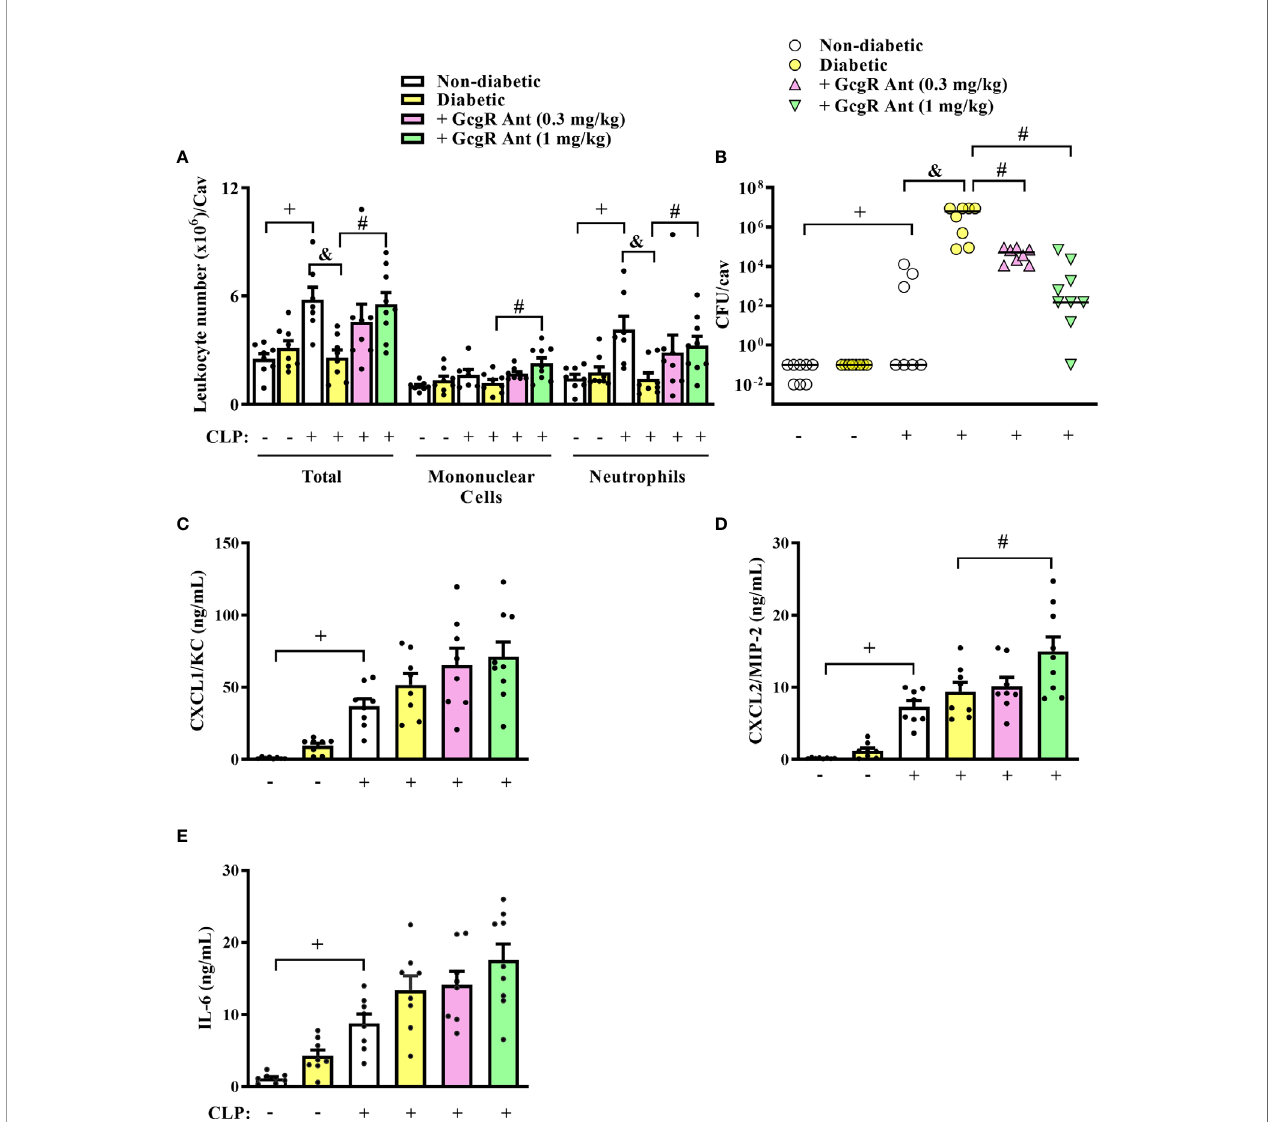
FIGURE 1 | GcgR antagonist restores neutrophil migration and inhibits CFU formation but does not alter chemokines and IL-6 production in the peritoneal cavity of diabetic mice after sepsis induction. CLP was performed 21 days after diabetes induction, and the treatment with GcgR antagonist was carried out 24h and 1h before CLP. (A) Analysis of total and differential leukocytes. (B) Bacterial load evaluation. (C – E) Peritoneal levels of CXCL1/KC, CXCL2/MIP-2, and IL-6, respectively. All the analysis were realized 3h after CLP. Each value represents the mean ± S.E.M. For (A, B) , each sample value was obtained in blinded and randomized counting. The statistical analysis was performed by one-way ANOVA, followed by Newman – Keuls – Student ’ s t-test. Results are representative of two independent assays. + P < 0.05 compared to sham non-diabetic mice. & P < 0.05 compared to CLP non-diabetic mice. # P < 0.05 compared to CLP diabetic mice. CFU, Colony- forming unit; CLP, Cecum ligation and puncture; GcgR Ant, GcgR